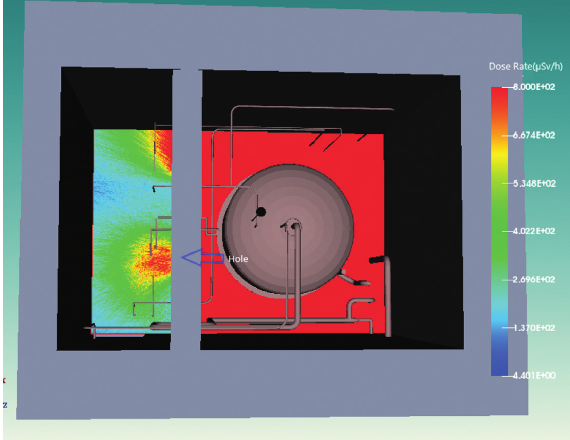
Figure 8: Shielding evaluation for the hole on the